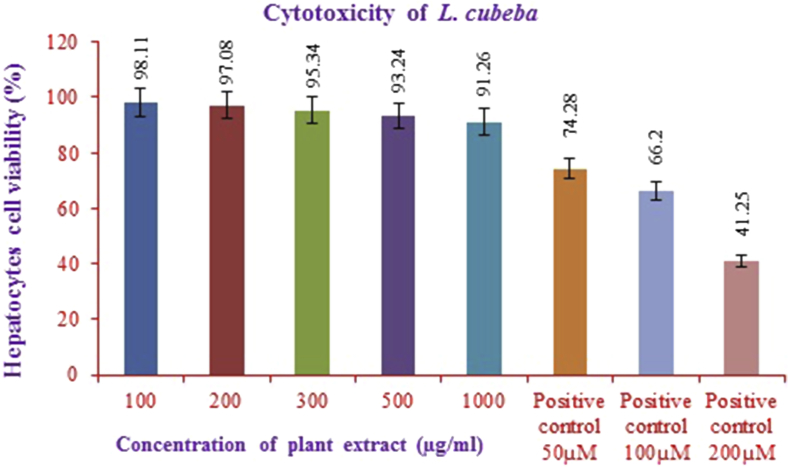
Cytotoxicity of L. cubeba and H2O2 (positive control).